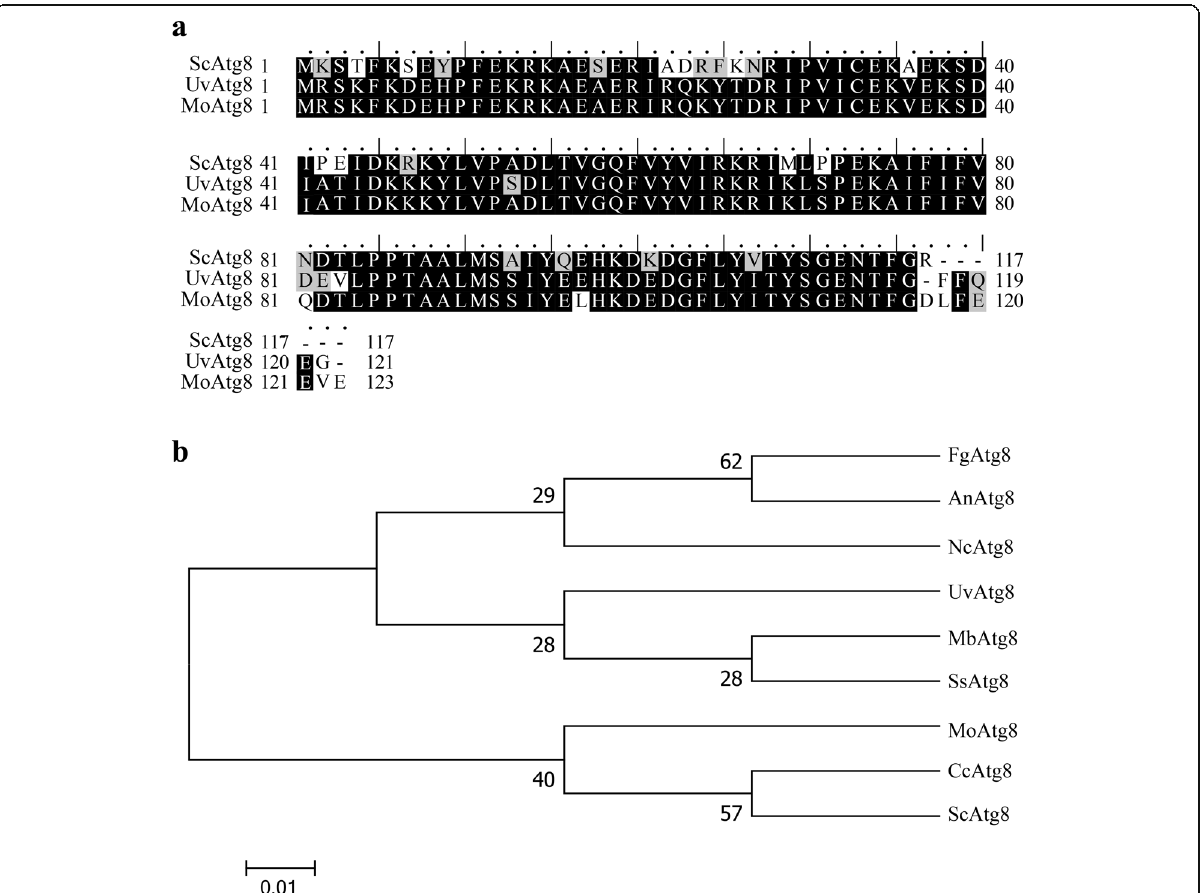
Fig. 1 Evolution analysis of UvAtg8. a, The mutiple alignment of amino acid sequences of UvAtg8, ScAtg8, and MoAtg8. The identitical amino acid were shaded in solid black, and the amino acids with 50 % similarity were highlighted in gray. b, Phylogenetic tree of Atg8 orthologs from different fungi was constructed by MEGA 5.0 using the neighbour-joining method. The sequences included FgAtg8 ( Fusarium graminearum, XP_001392077.1), AnAtg8 ( Aspergillus niger , XP_001392077.1), NcAtg8 ( Neurospora crassa , XP_956248.1), UvAtg8 ( Ustilaginoidea virens, KDB12146.1), MbAtg8 ( Metarhizium brunneum , XP_014545792.1), SsAtg8 ( Sclerotinia sclerotiorum , XP_001597408.1), MoAtg8 ( Magnaporthe oryzae , XP_003717877.1), CcAtg8 ( Coprinopsis cinerea , XP_001833603.1), and ScAtg8 ( Saccharomyces cerevisiae ,